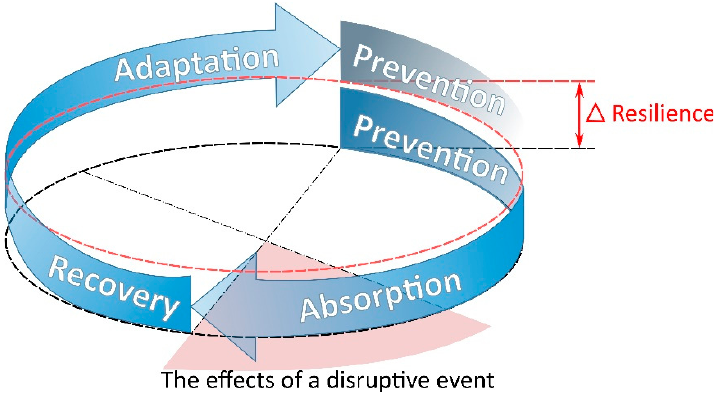
Figure 1. Cycle of strengthening the resilience of energy critical infrastructure elements